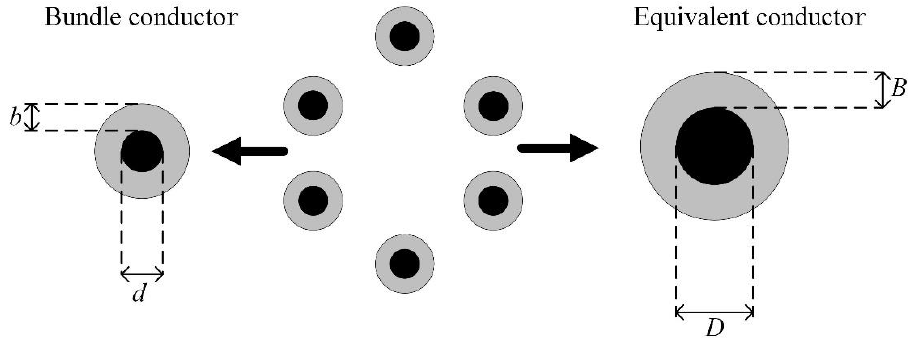
Figure 3. Equivalent conductor diagram.